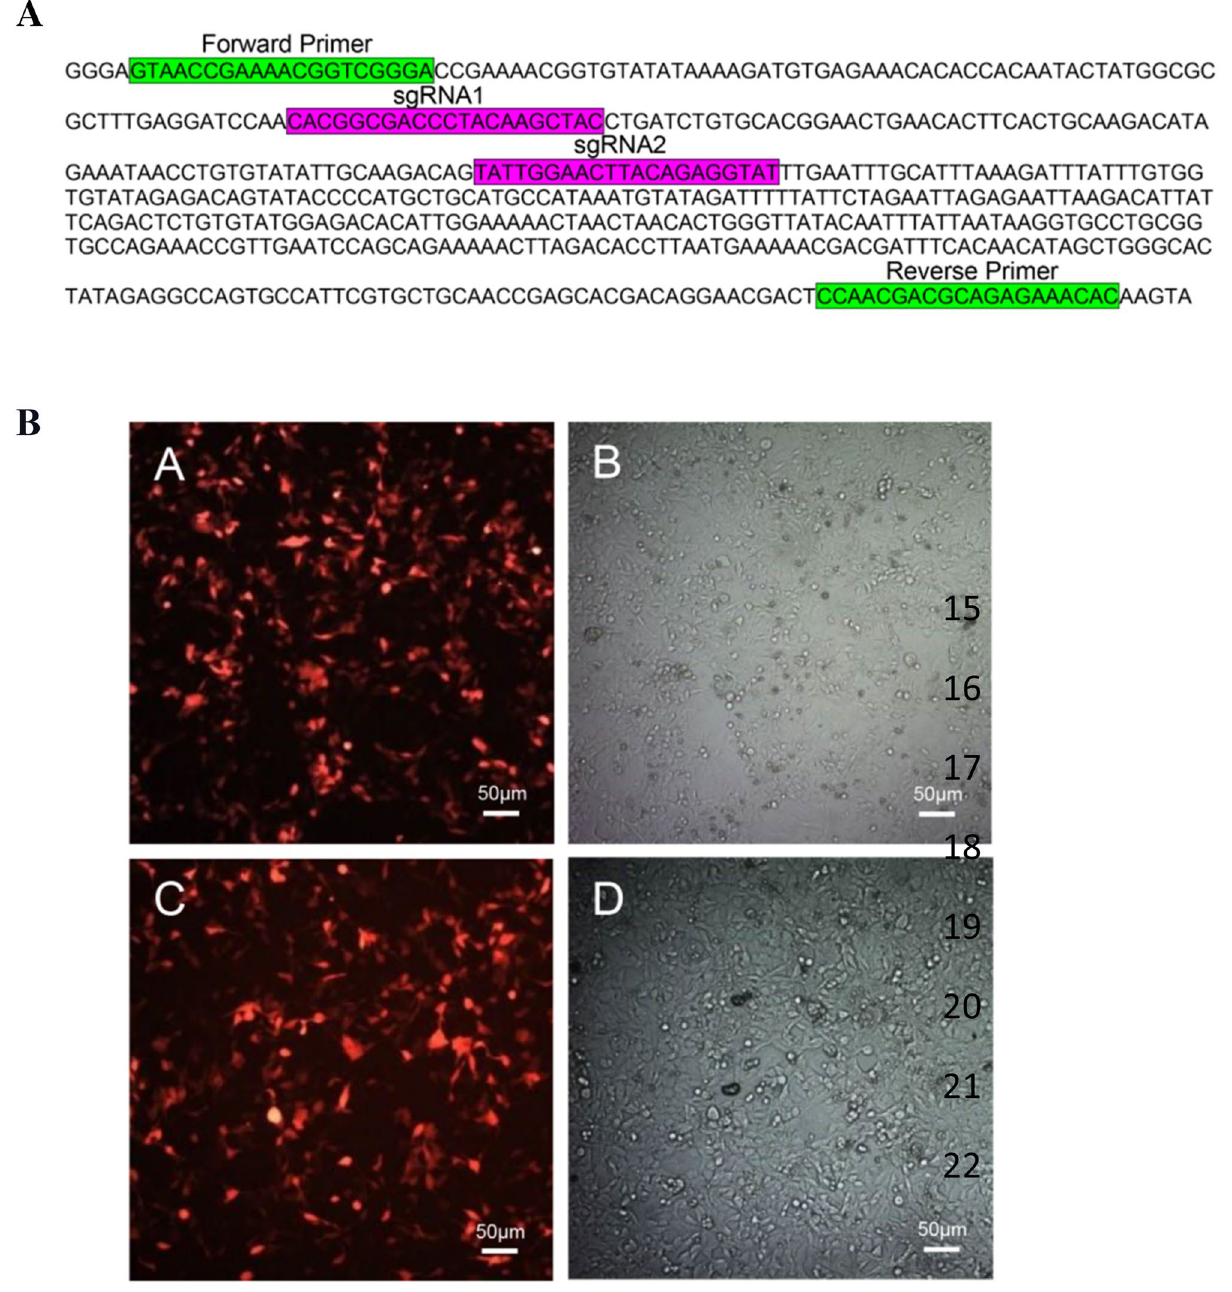
Figure 1. Editing tool preparation. ( A ) The position of two sgRNAs and the primers used in this study. sgRNA-1 for minus strand, and sgRNA-2 for plus strand of the gene. ( B ) To optimized cell transduction, RFP expression was visualized directly using fluorescence microscopy (Scale bars = 50 μM). ( A ) HeLa cells infected with AAV-E6 sgRNAs/Cas9 virions and ( B ) Bright field. ( C ) HEK293t cells co-transfected with triple vectors PX601-mCherry, pHelper, and pAAV-RC for production of AAV-E6-CRISPR/Cas9 particles and ( D ) Bright